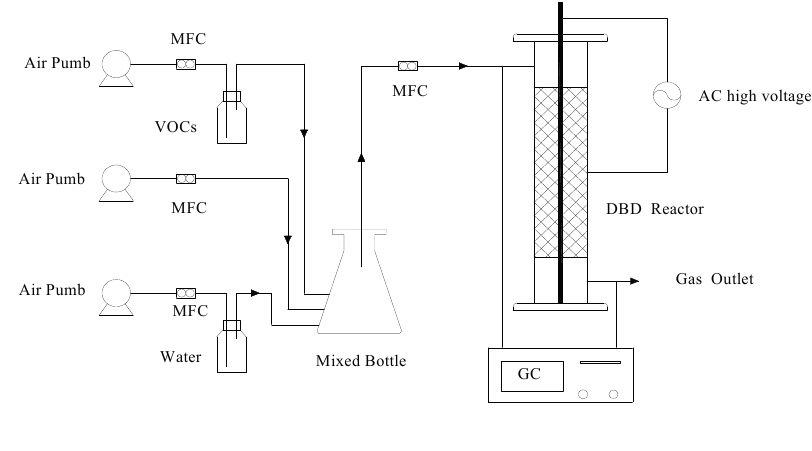
Figure 2. Schematic of the experimental